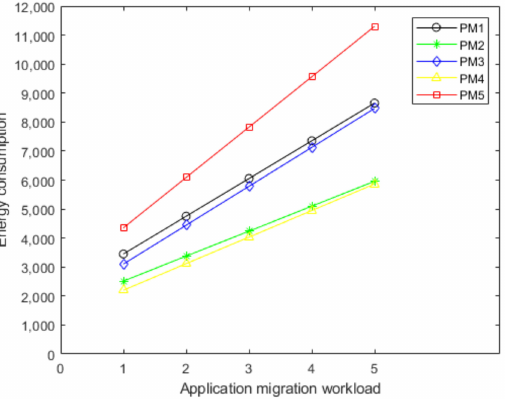
Figure 5. Energy consumption cost of cloud provider without considering processing time of application migration.